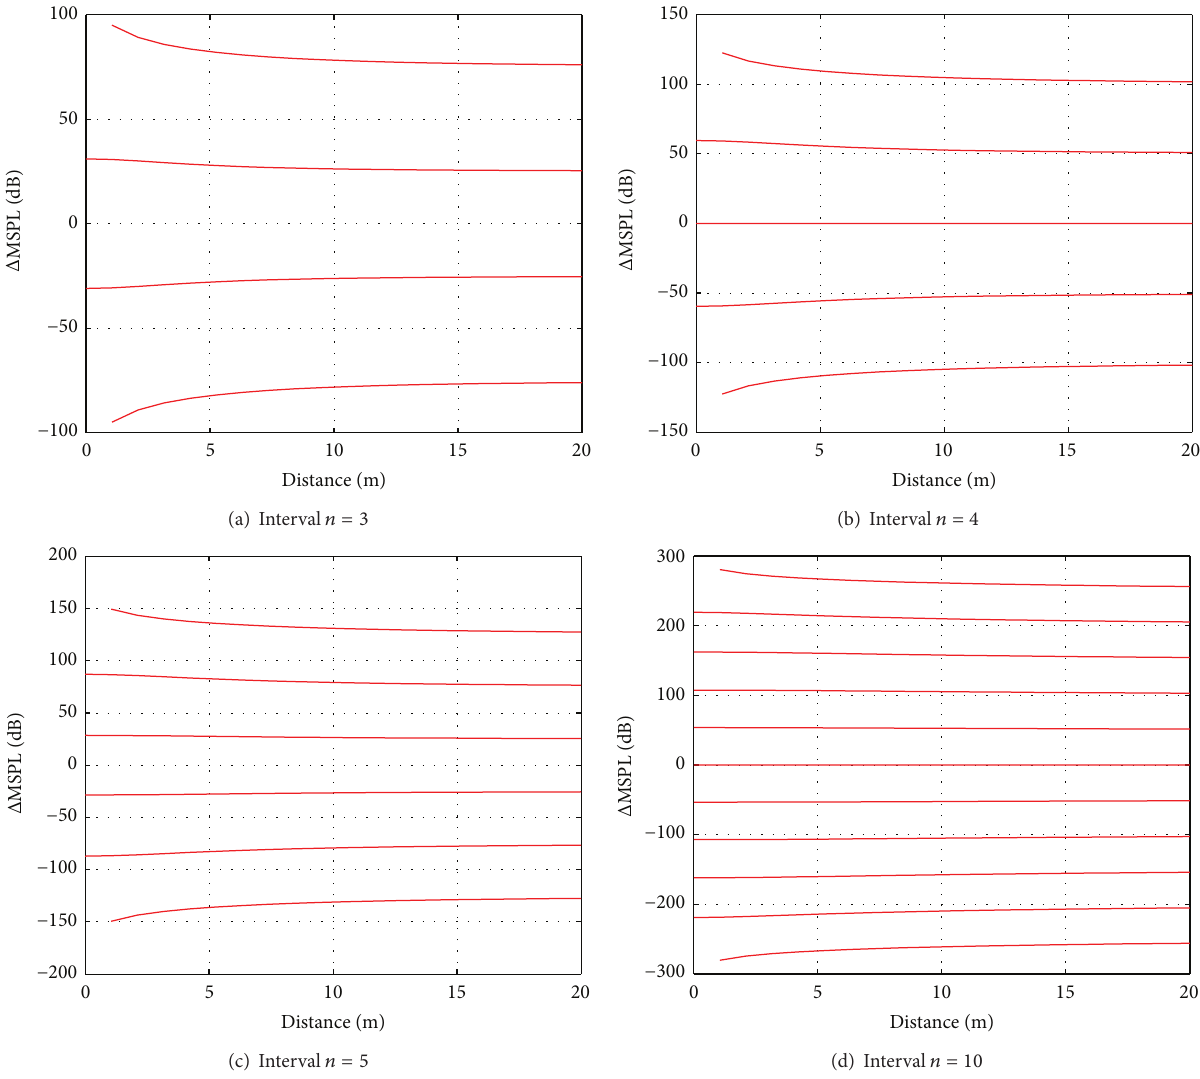
Figure 3: Different Δ MSPL when interval